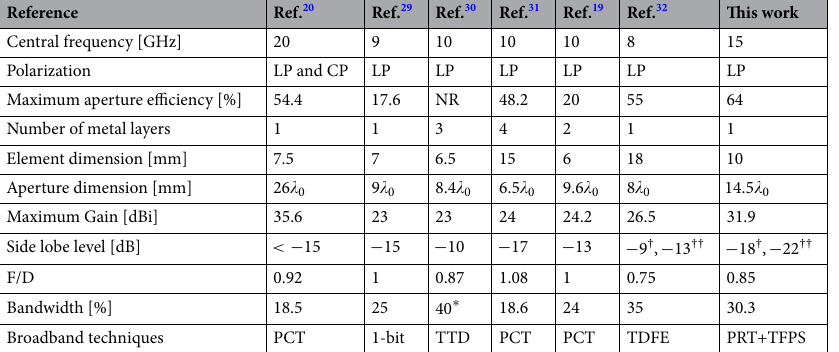
Reference Ref. 20 Ref. 29 Ref. 30 Ref. 31 Ref. 19 Ref.